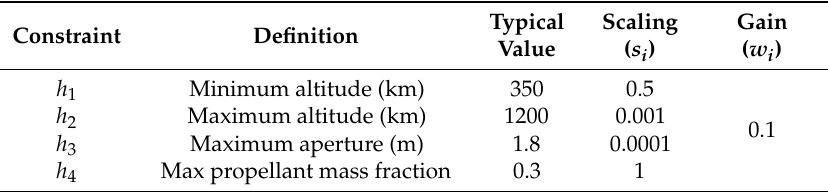
Table 12. Constraints, scaling factors, and gains in single-objective optimization.